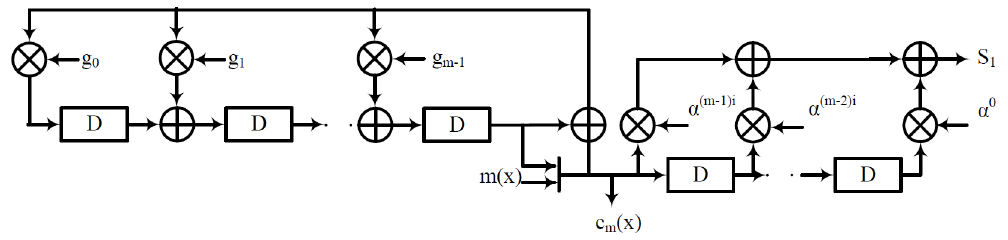
Figure 1. Area-efficient syndrome